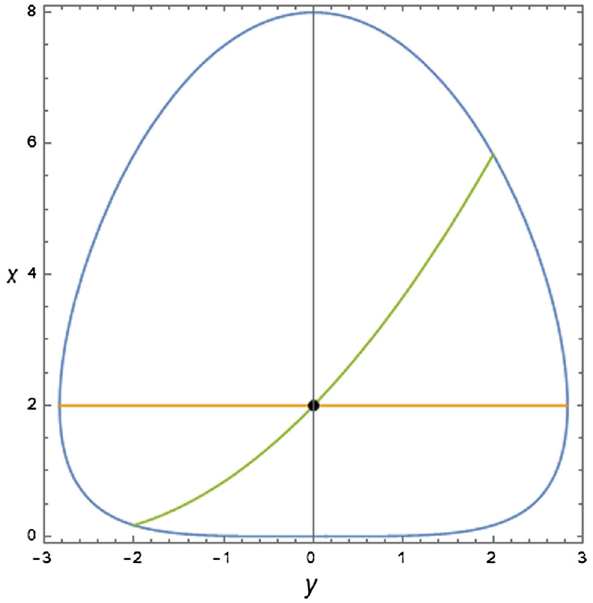
Fig. 1 Projection of the 3-sphere in Rindler space (blue) onto the x - y - planefor α = 1 / 2and c = 1( l 0 = 4).Theaccelerationisin x -direction, y (and z ) are perpendicular to the acceleration (see text). The black dot at ( l 0 / 2 , 0 , 0 ) is the center of the sphere in Rindler coordinates with √ radius r = l 0 / 2. Also shown are diameters of geodesic length 2 r (orange and green). The corresponding Euclidean 3-sphere of the same diameter is shown in